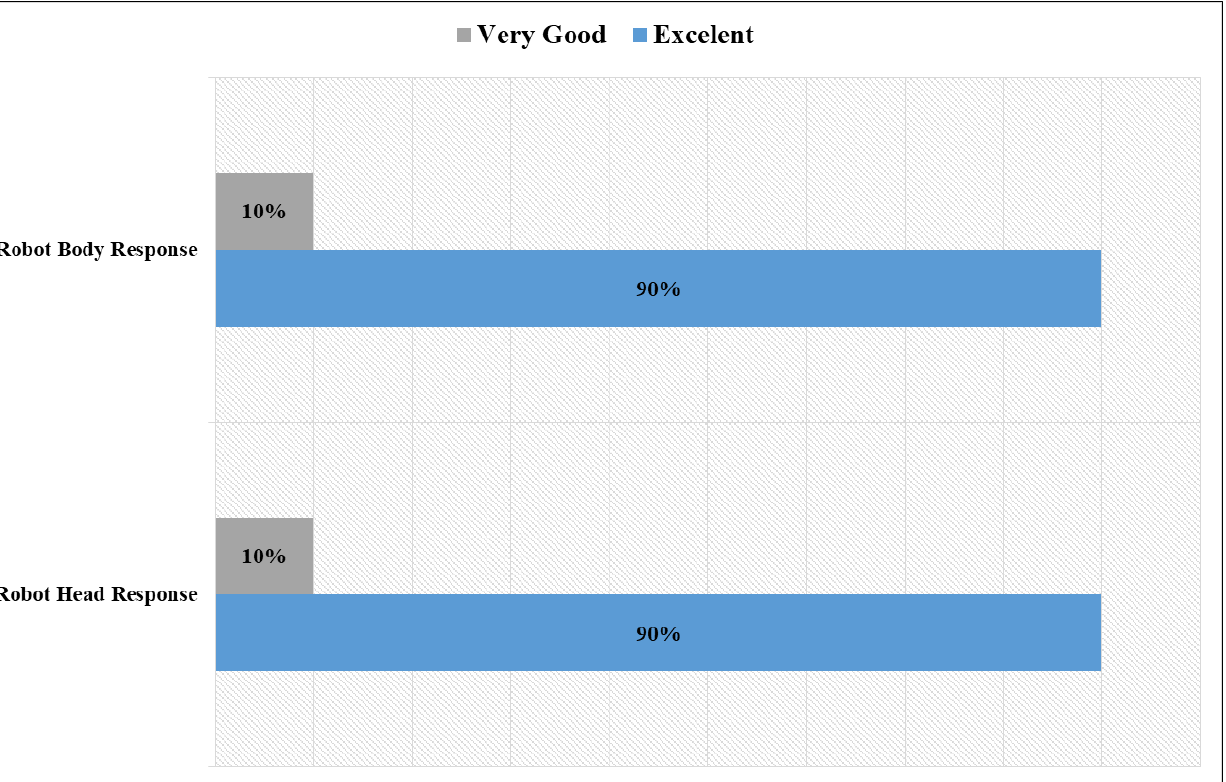
Figure 14. Feedback on robot hardware components.